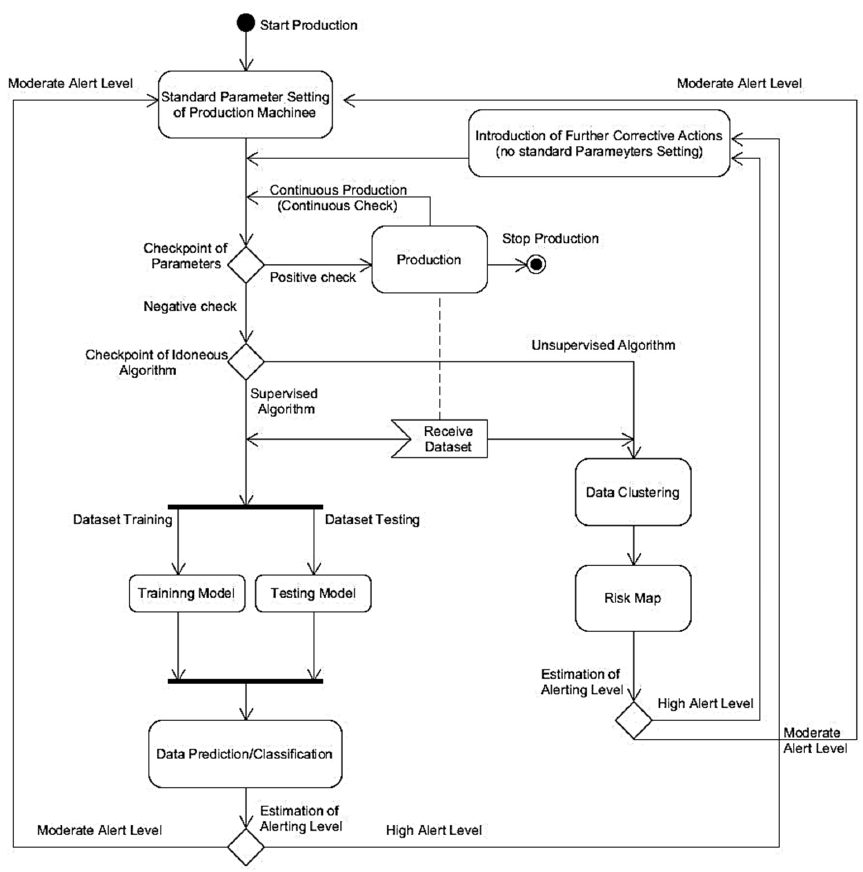
Figure 3. UML-AD theoretical model of the proposed PM.